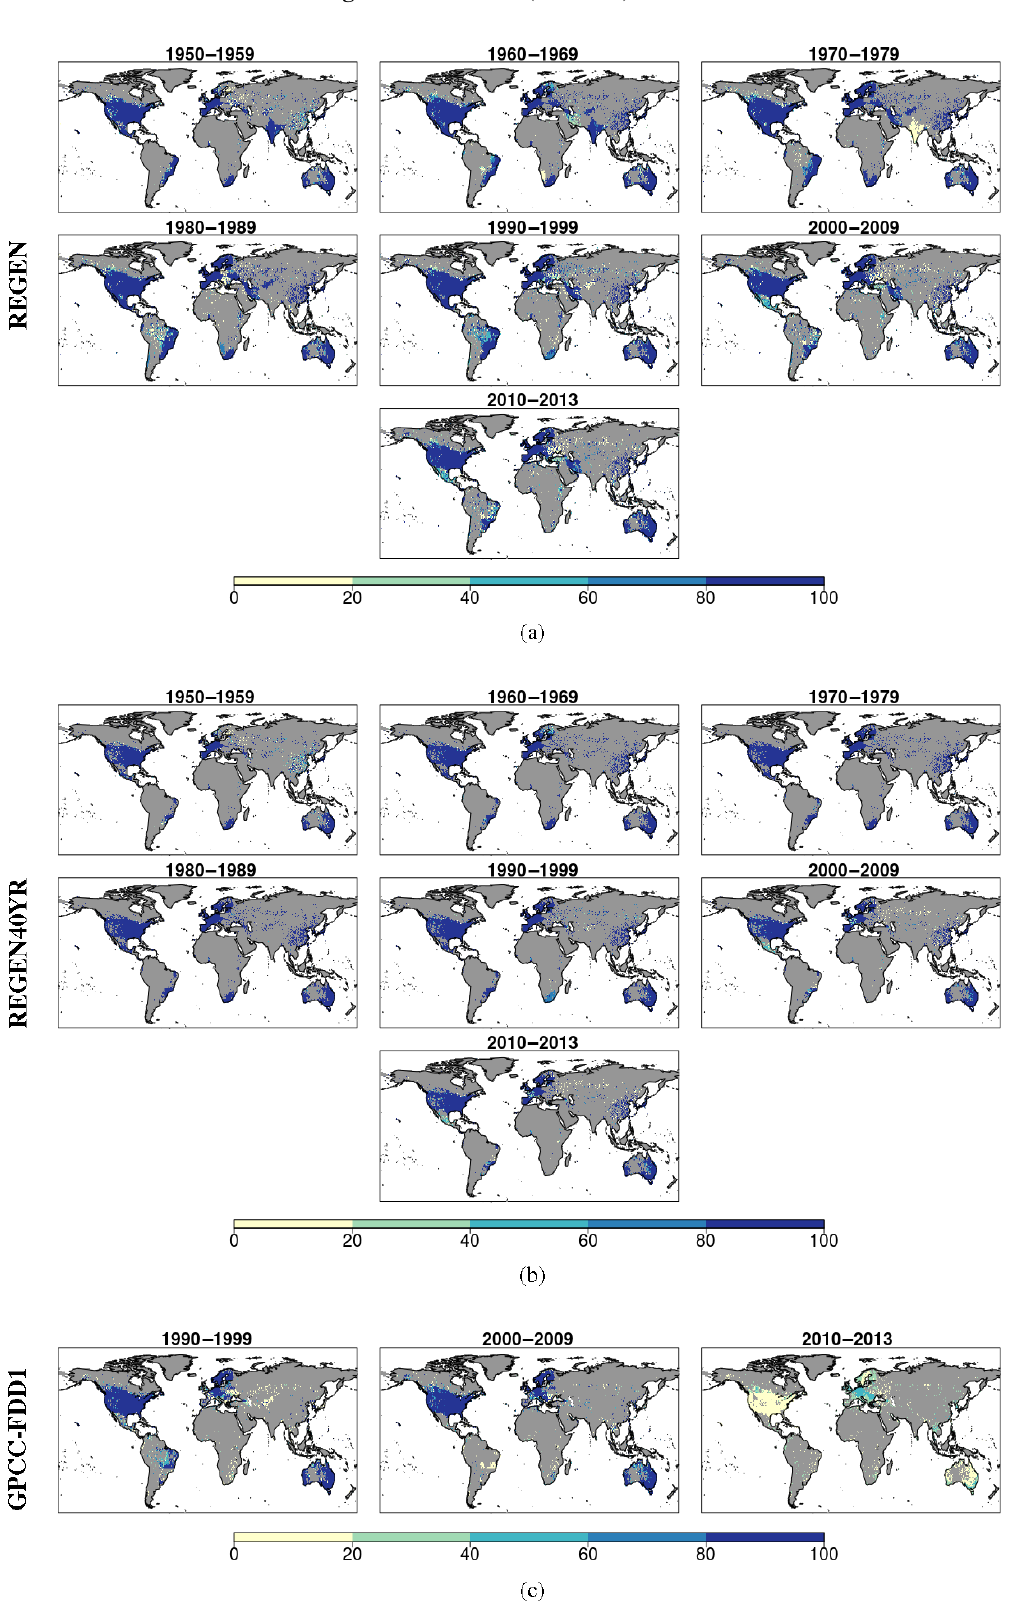
Figure 3. Grids showing percentage of days with at least one station in each decade for (a) REGEN, (b) REGEN40YR and (c) GPCC-FDD1. Grey areas indicate grids where no stations are